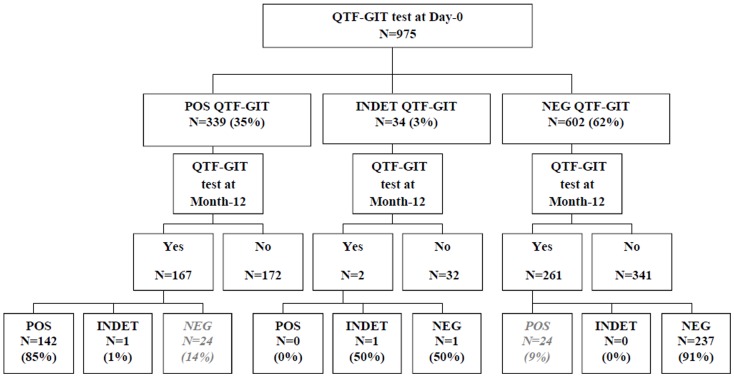
Flow chart.POS: Positive QuantiFERON TB Gold in-tube test; NEG: Positive QuantiFERON TB Gold in-tube test; INDET: Indeterminate QuantiFERON TB Gold in-tube test.